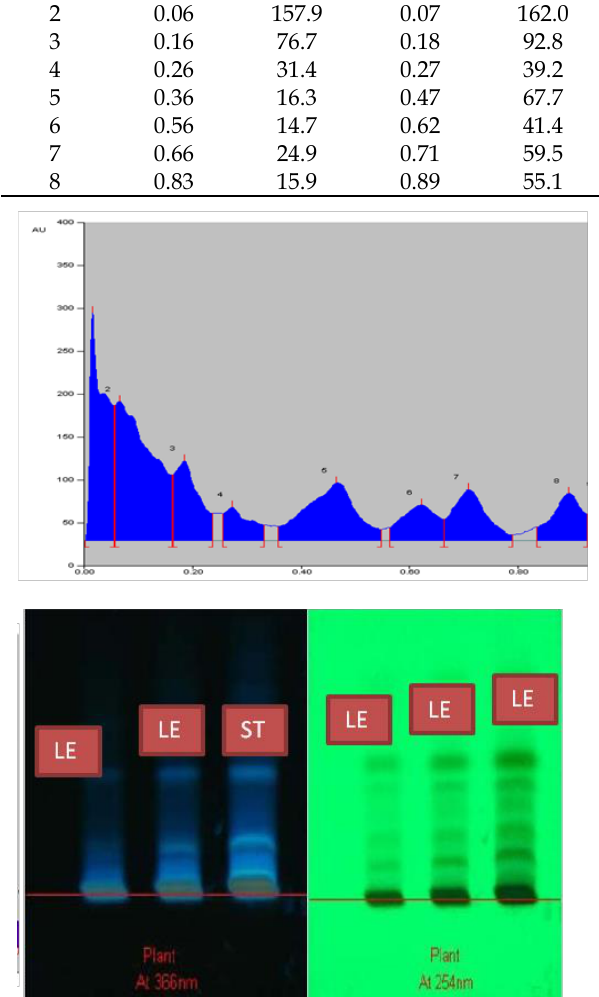
Figure 7: HPTLC profile of hydroalcoholic of R. indica with standard saponin .